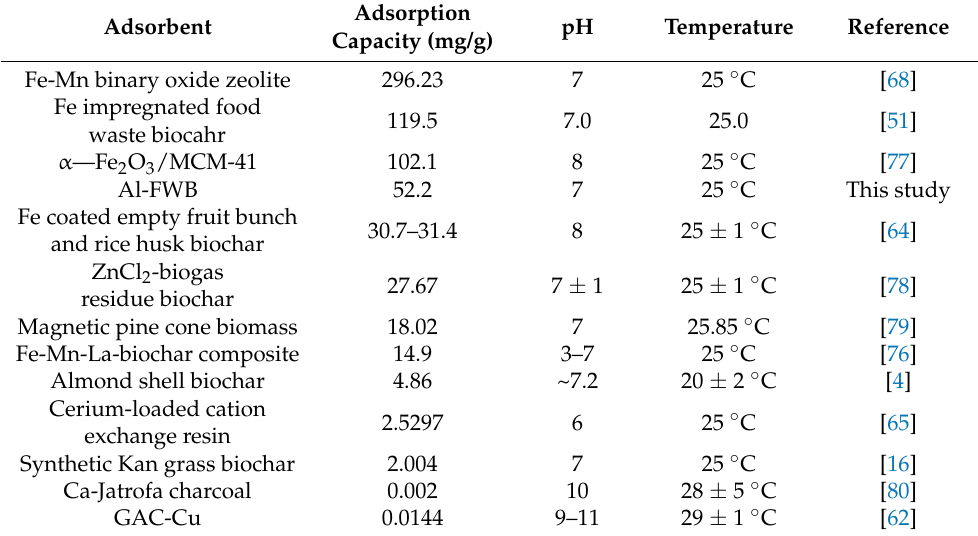
Table 6. Comparison of the adsorption capacity of different adsorbents for As(III)